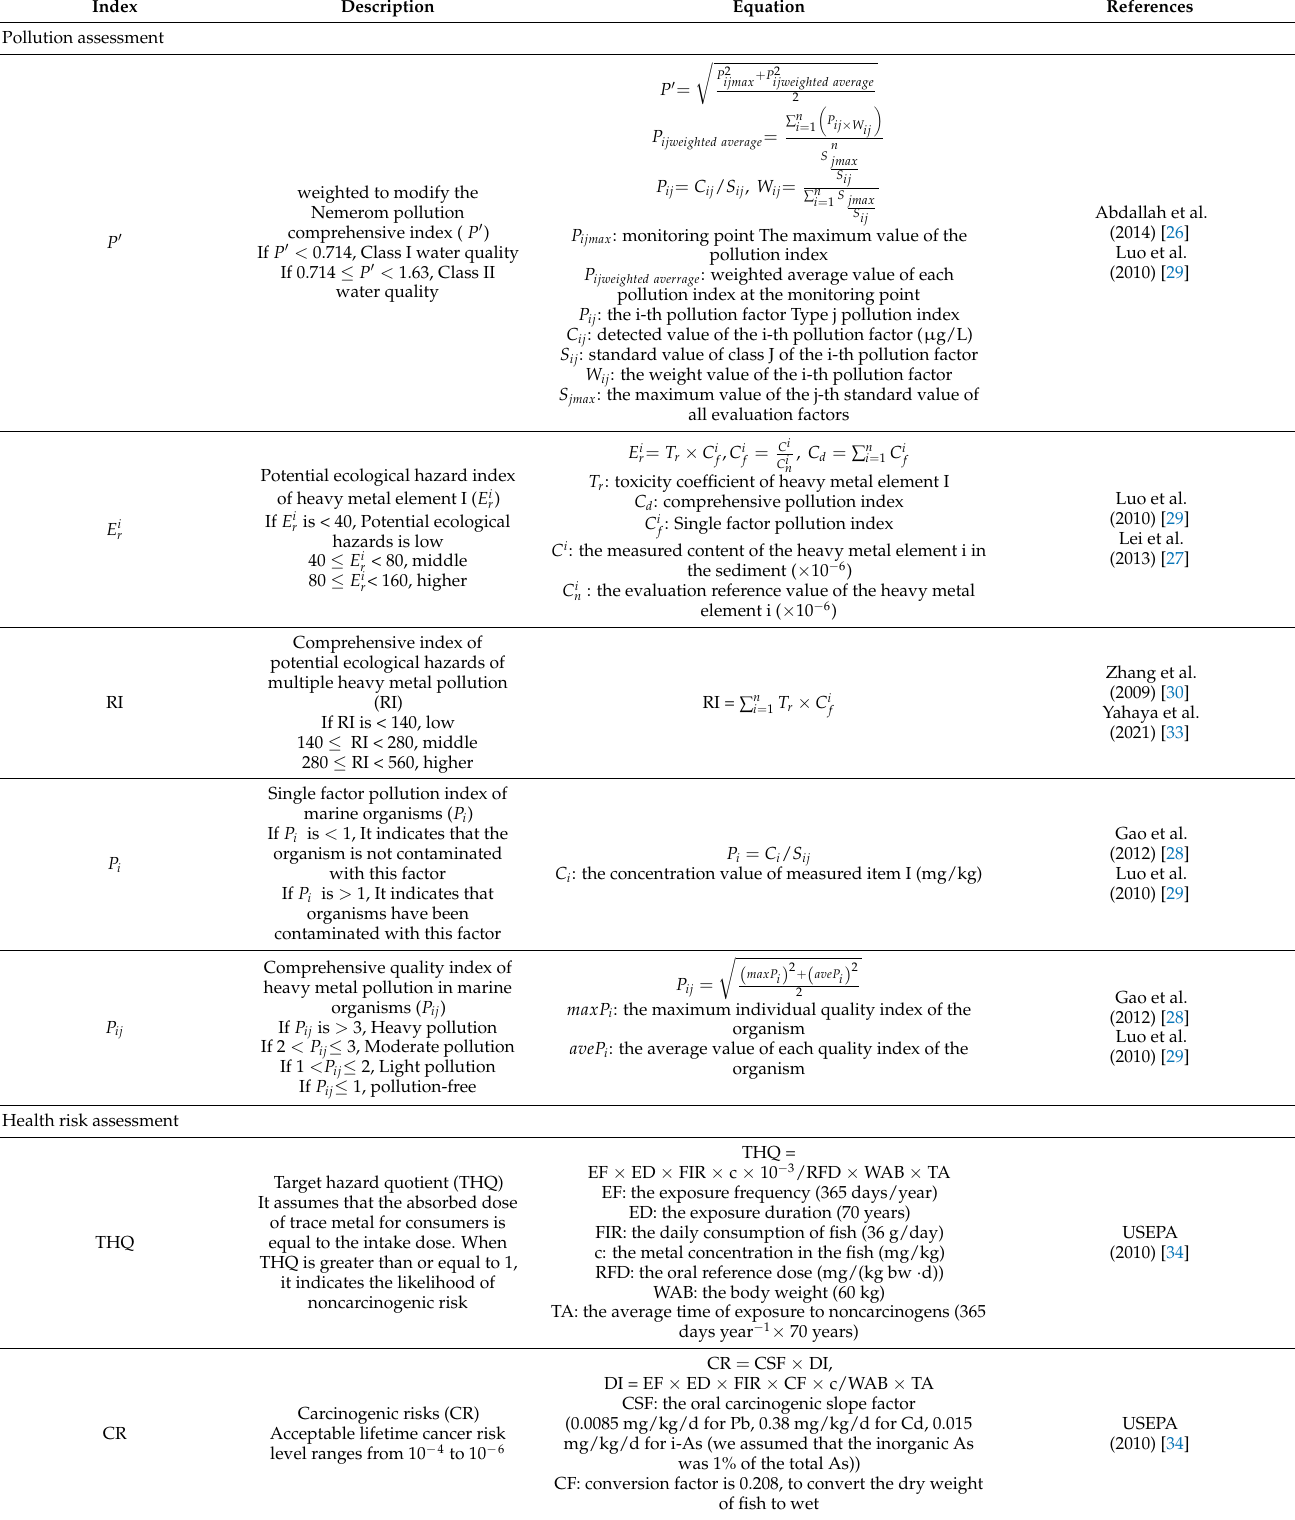
Table 1. Parameters of pollution and health risk